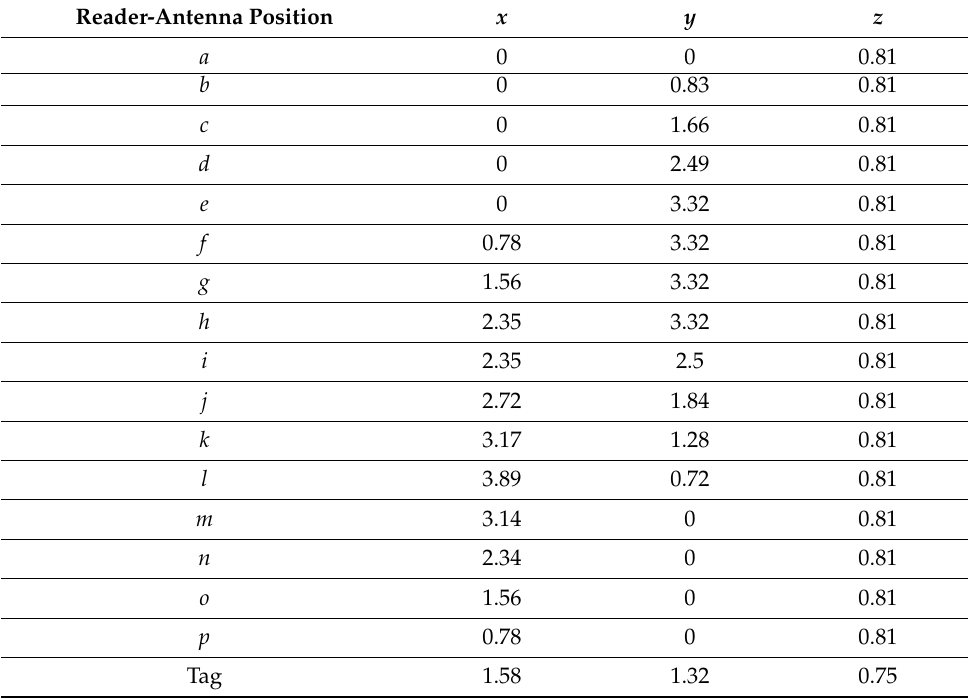
Figure 3. Laboratory room/Simulated ward with reader–antennas and tag positions. Table 1. Reader–antenna coordinates in laboratory room/simulated